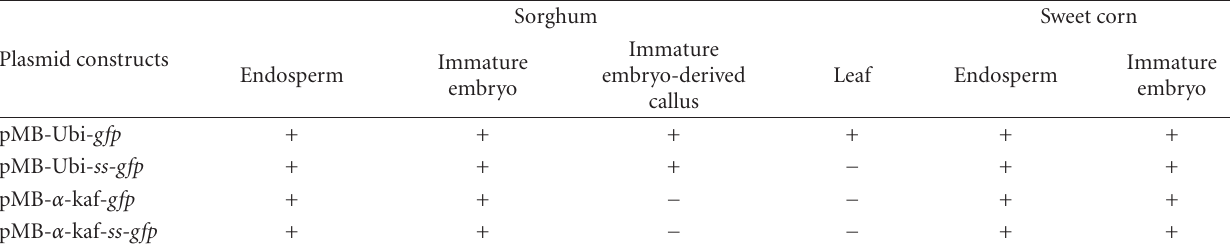
Immature embryo